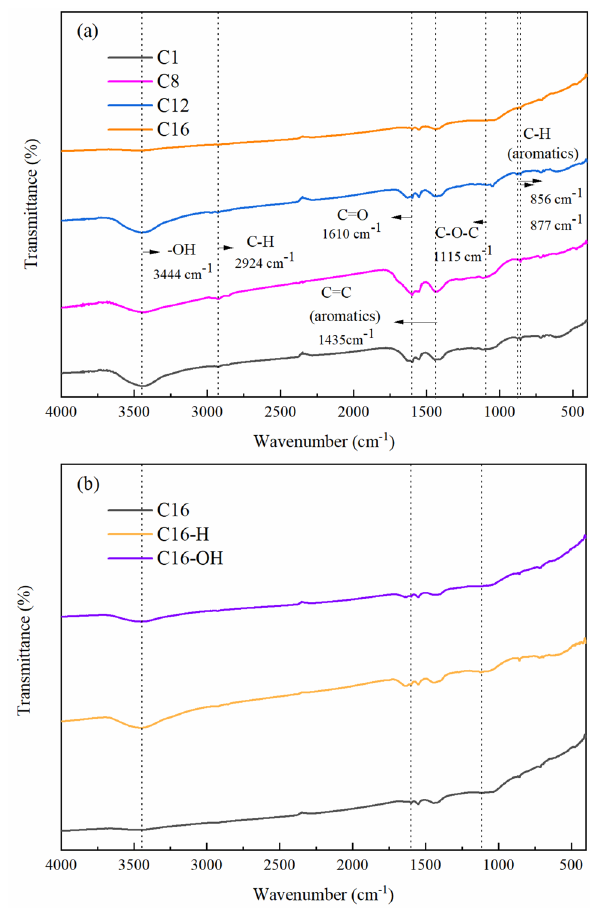
Figure 5. FTIR spectra of corn stover biochar: ( a ) different pyrolysis temperatures and ( b ) different modification treatments.